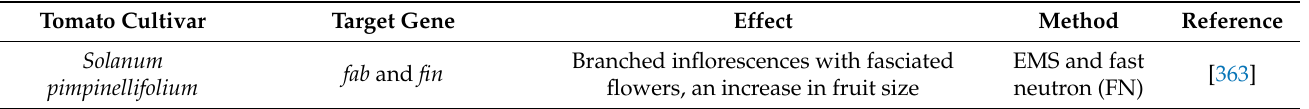
Table 4. List of gene editing for yield and fruit quality improvement in tomato. AGAMOUS-LIKE6 (SlAGL6), Alcobaca (ALC), Anthocycanin1 (ANT1), ARGONAUTE7 (AGO7), Aux/IAA9 transcription factor (SlIAA9), BLADE-ON-PETIOLE family (BOP1, BOP2, BOP3), mitochondrial transcription factor A (TFAM1, TFAM2), Carotenoid isomerase (CRTISO), CLAVATA3 (CLV3), Defective chloroplasts and leaves (DCL), DELLA (aspartic acid–glutamic acid–leucine–leucine–alanine), fasciated and branched (fab) and fasciated inflorescence (fin), FEEBLY (FB), GDP-L-GALACTOSE PHOSPHORYLASE (GGP1), LEAFY-COTYLEDON1-LIKE4 (L1L4), LYCOPENE BETA CYCLASE (CycB), MULTIFLORA (MULT), organelle RNA recognition motif-containing protein4 (ORRM4), OVATE (O), Phytoene desaturase (PDS), pyruvate-dependent GABA-T family proteins (GABA-TP1, GABA-TP2, GABA-TP3), cationic amino acid transporter 9 (CAT9), succinate semialdehyde dehydrogenase (SSADH), RIPENING INHIBITOR (RIN), SELF PRUNING (SP), SELF PRUNING 5G (SP5G), SHORT ROOT (SHR), stay-green 1 (SGR1), lycopene ε -cyclase (LCY-E), beta-lycopene cyclase (Blc), lycopene b-cyclase 1 (LCY-B2), WUSCHEL (WUS). Tomato Cultivar Target Gene Effect Solanum Branched inflorescences with fasciated fab and fin pimpinellifolium flowers, an increase in fruit